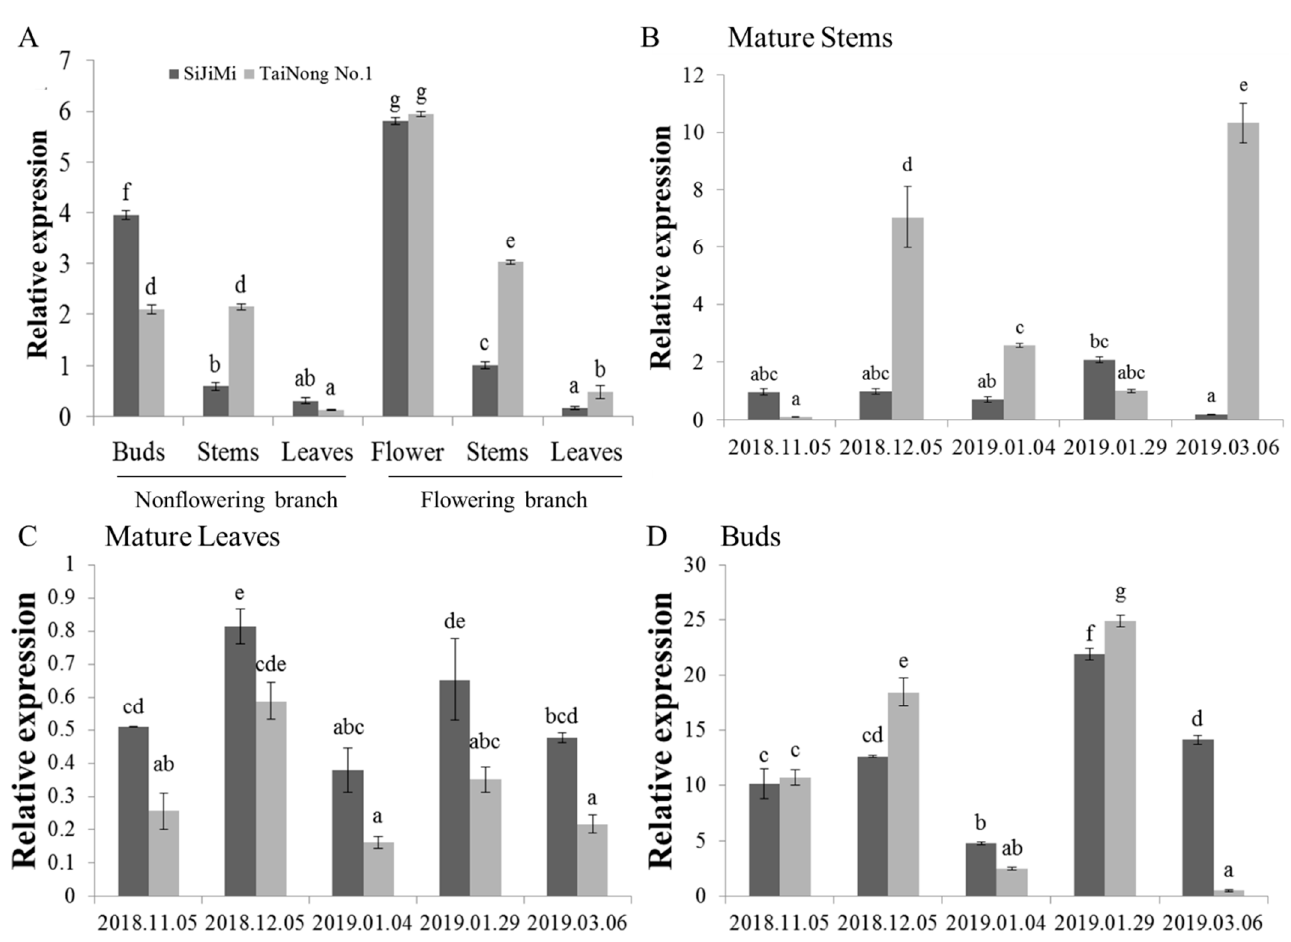
Figure 2. Relative expression levels of the MiLFY gene. ( A ) Tissue expression patterns of the MiLFY gene in buds/flowers, stems, and leaves of nonflowering and flowering branches. ( B ) Expression patterns of the MiLFY gene in mature stems during different flower development stages. ( C ) Temporal expression pattern of the MiLFY gene in mature leaves during different flower development stages. ( D ) Temporal expression pattern of the MiLFY gene in buds during different flower development stages. Significant differences among the samples were assessed at the p < 0.01 level by Student’s t tests; different letters indicate significance between different samples.